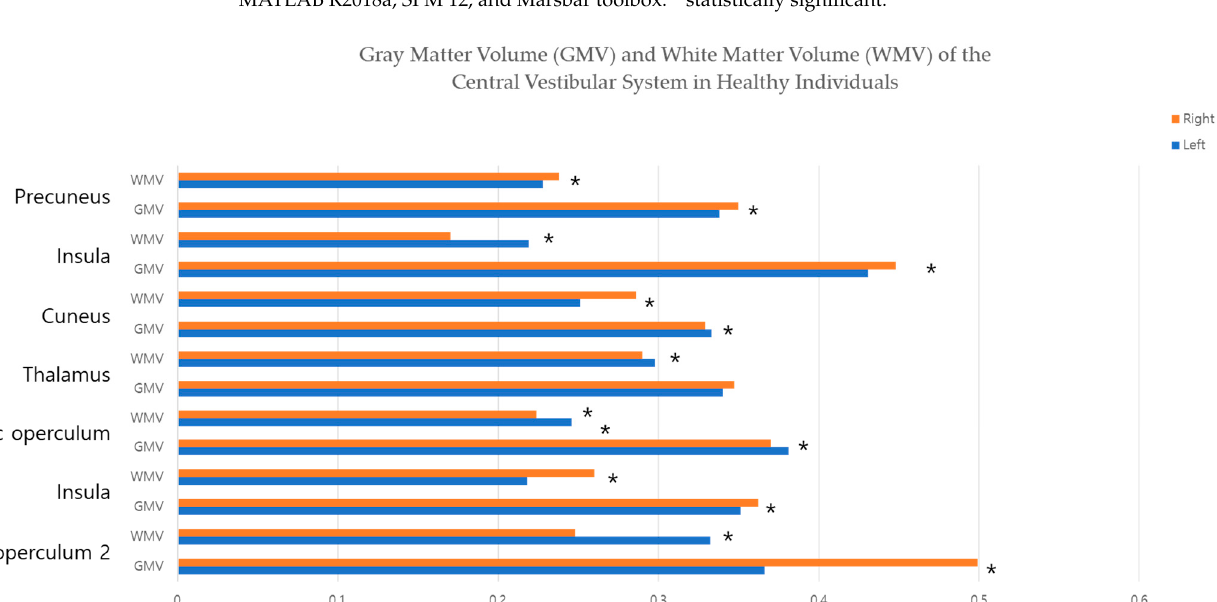
Table 2. Brain Metabolites of the Parietal Operculum 2 a. Metabolite of Parietal Operculum 2